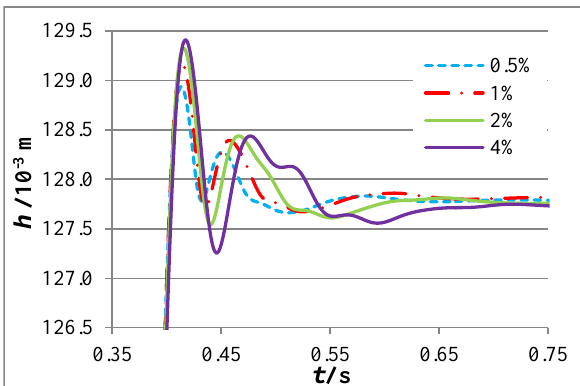
Fig. 11. Influence of undissolved air content (in %) on position response . Table 2. Influence of undissolved air content on overshoot of piston